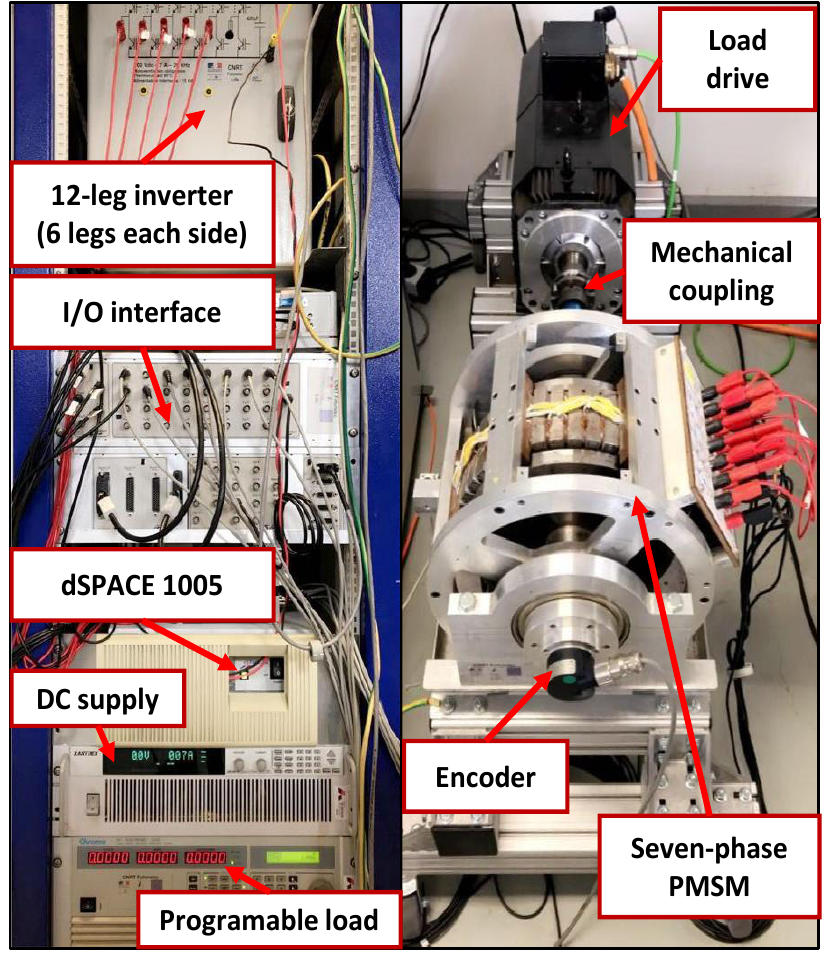
Figure 23. Experimental test bench of the seven-phase PMSM.